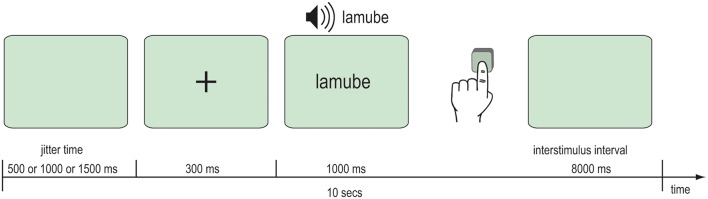
Scanning procedure.